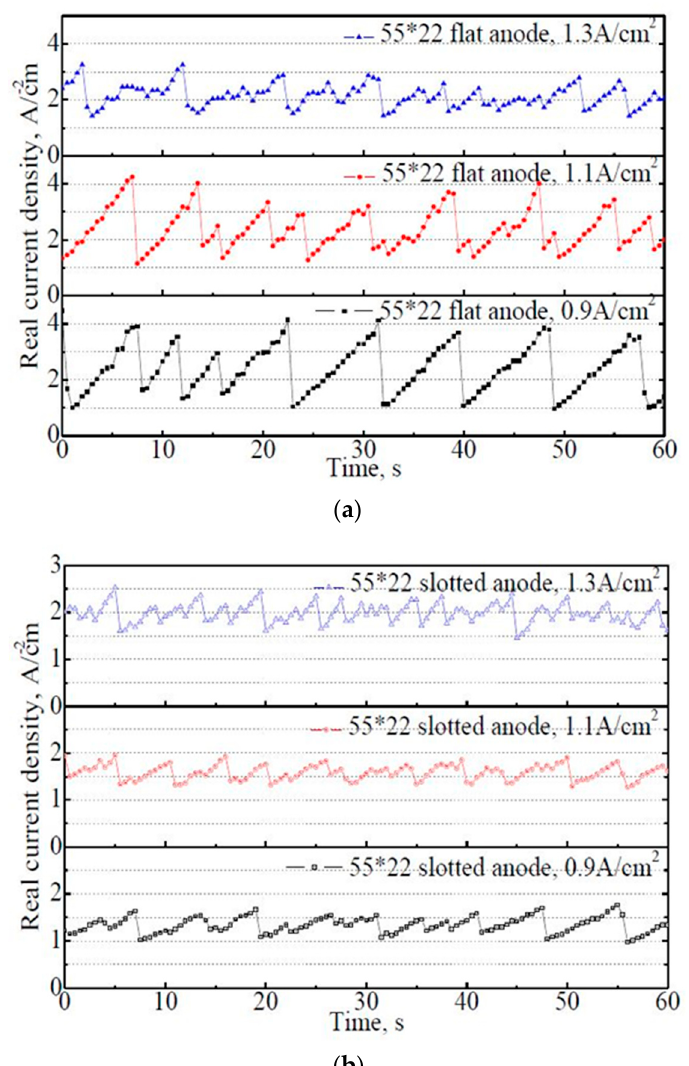
Figure 7. The variation of actual current density on the 50 mm × 22 mm flat and slotted anodes within 60 s. ( a ) 50 mm × 22 mm flat anode, ( b ) 50 mm × 22 mm slotted anode.